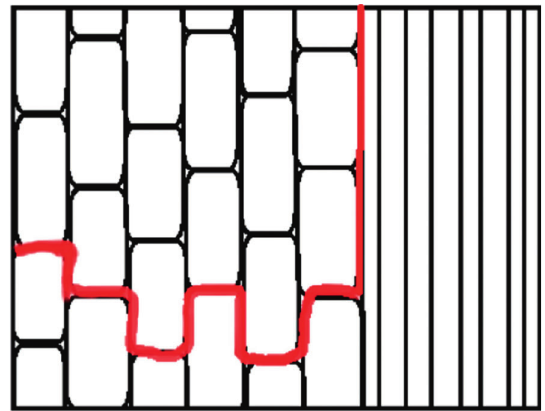
Figure 5: Schematic diagram showing the proposed crack prop- agation path in the bamboo tensile test.